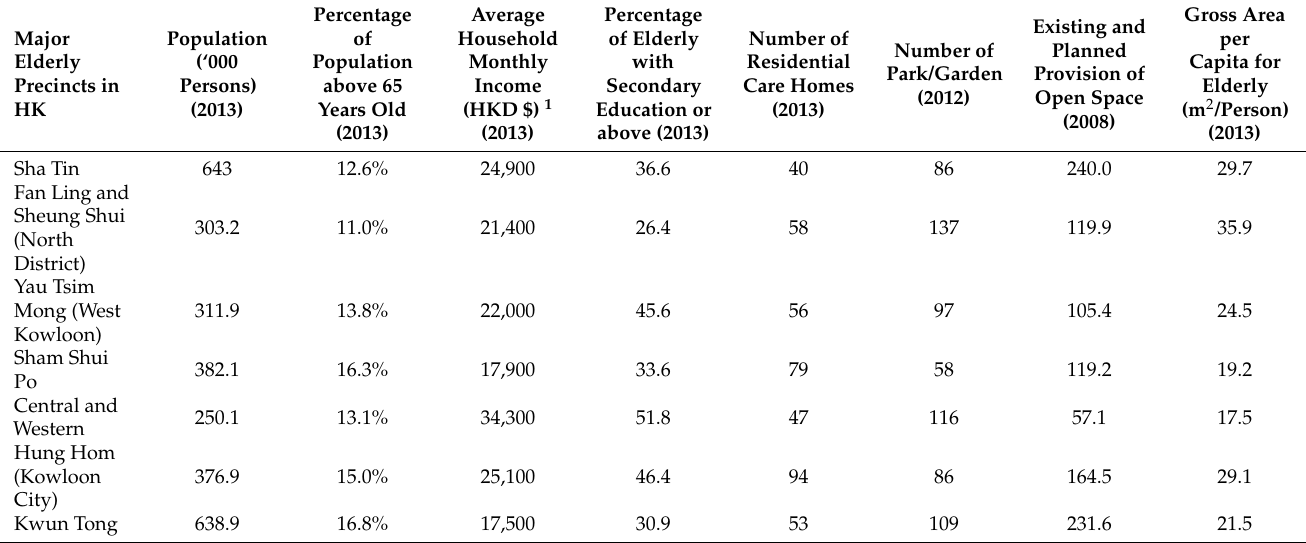
Table 1. Profile of the selected